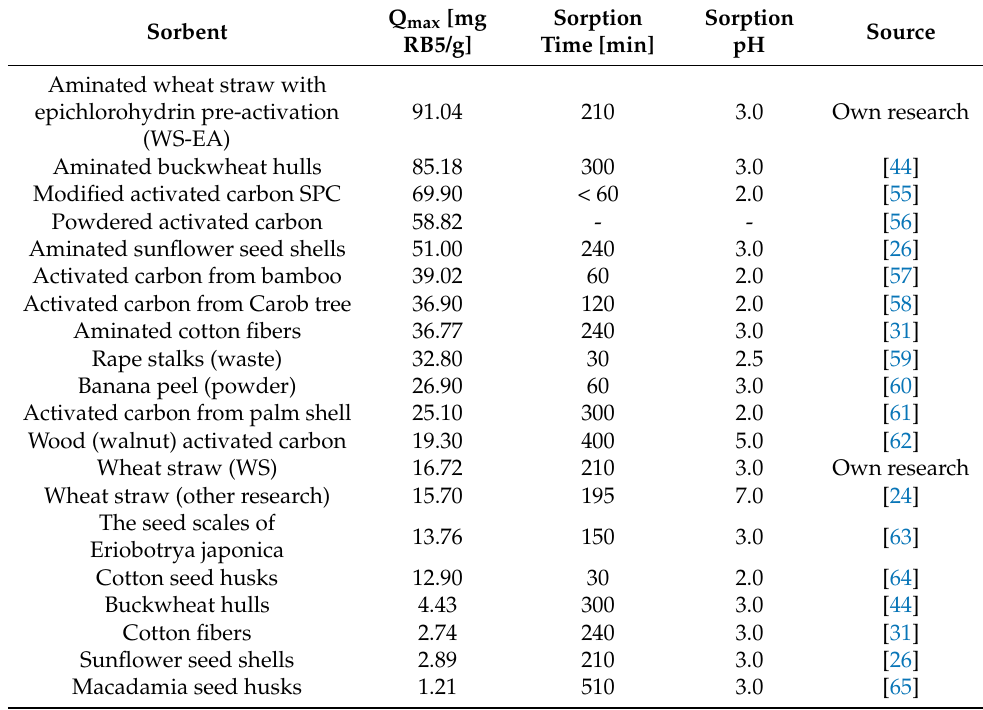
Table 6. Comparison of RB5 sorption on unconventional sorbents and selected materials based on active